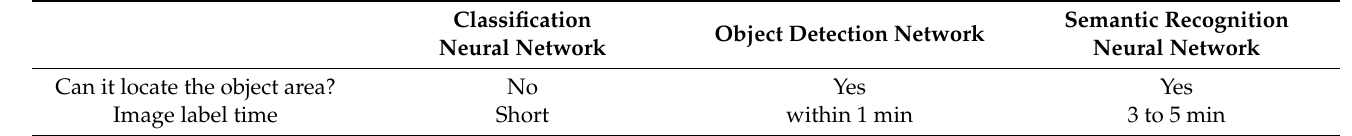
Table 1. Neural network selection evaluation